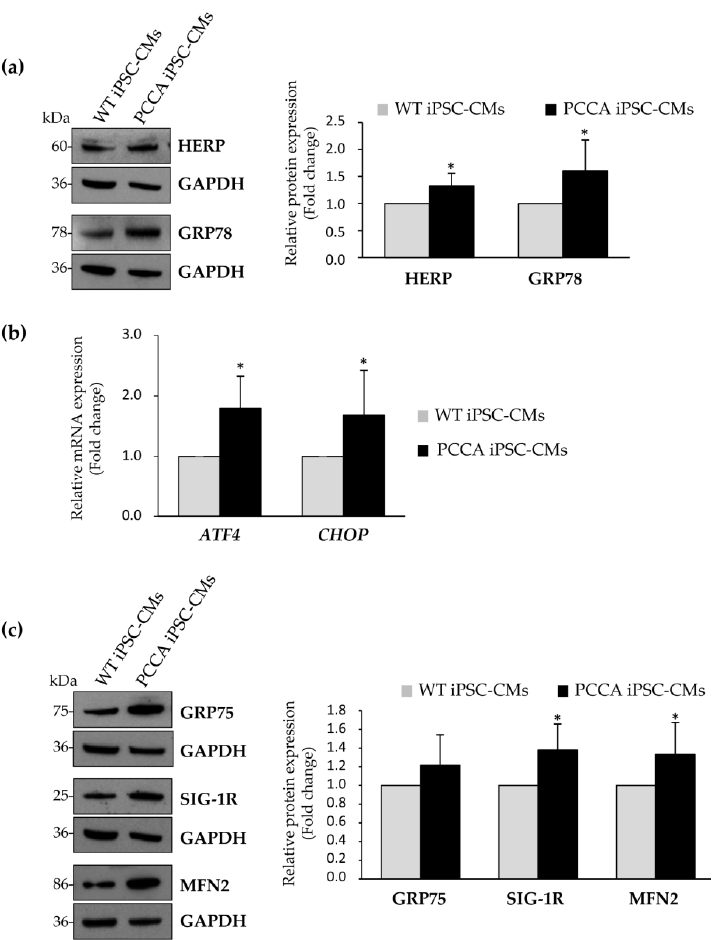
Figure 3. Evaluation of protein and mRNA levels involved in the unfolded protein response (UPR) and mitochondria-associated membranes (MAMs) in WT and PCCA iPSC-CMs. ( a , b ) Expression analysis of several proteins involved in the UPR by western blot ( a ) or by qRT-PCR ( b ). ( c ) Analysis of protein levels of MAMs proteins by western blot. In panels ( a , c ), representative blots and the corresponding quantification of proteins by laser densitometry are shown as the mean ± standard deviation of at least three experiments. In each blot, GADPH is used as a loading control. In ( b ), data represents the mean ± standard deviation of at least three independent cardiomyocyte differentiation triplicates. Statistical significance is determined by Student’s t -test. * p <